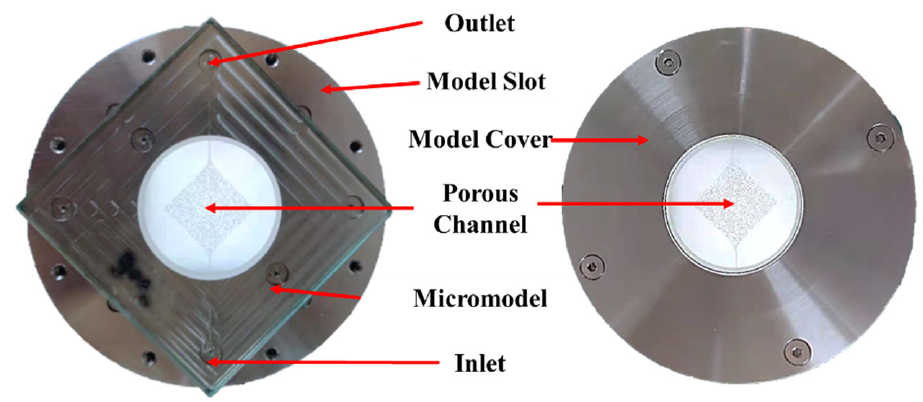
Figure 1. Micromodel setup.